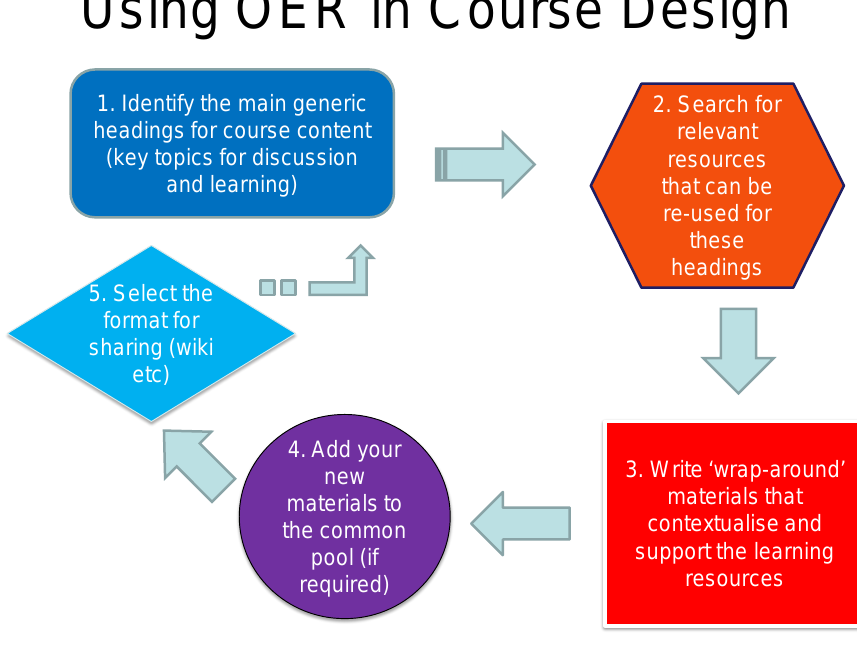
Figure 3 . Summary of course design process using